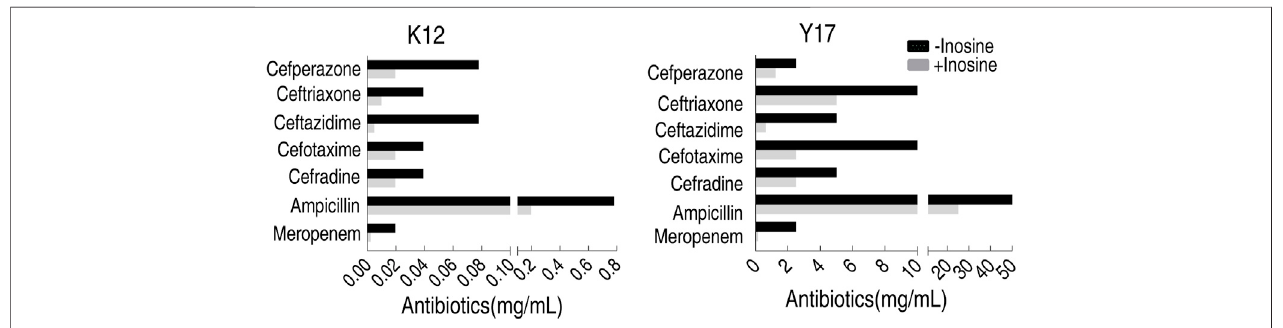
FIGURE 5 | MKC of K12 and Y17 in the presence or absence of 5 mM inosine by seven antibiotics.